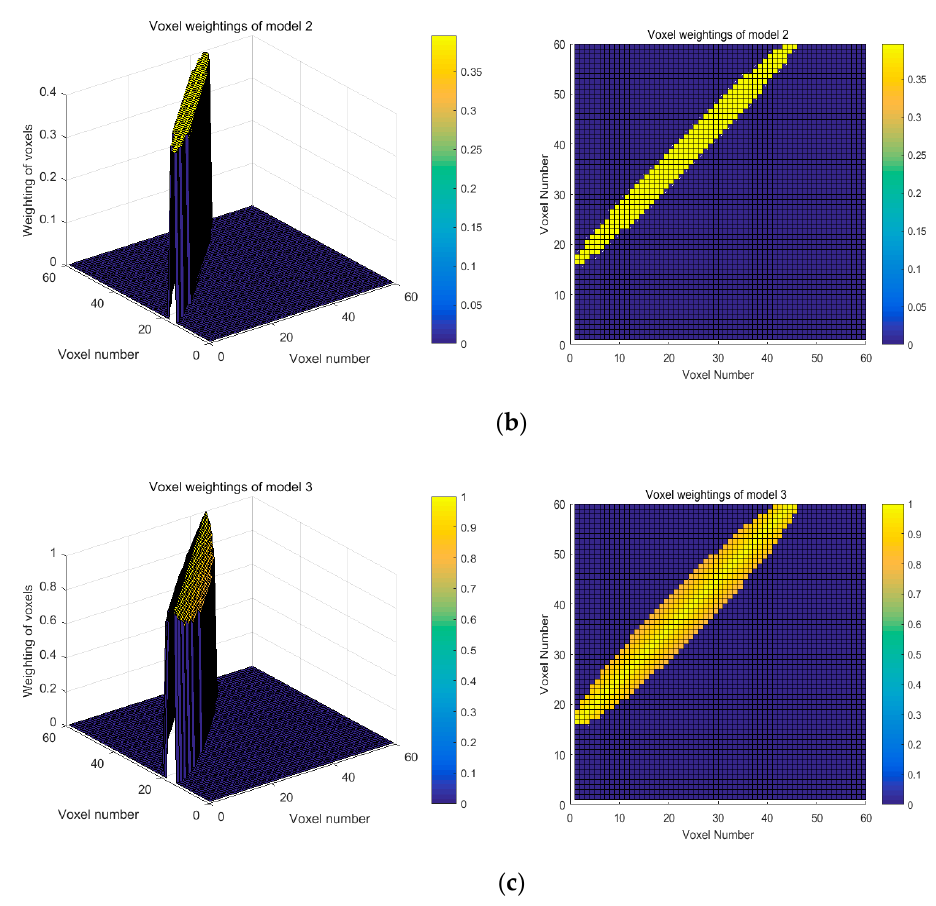
Figure 5. Voxel weightings distribution of different models ( a ) Model 1; ( b ) Model 2; ( c ) Model 3.